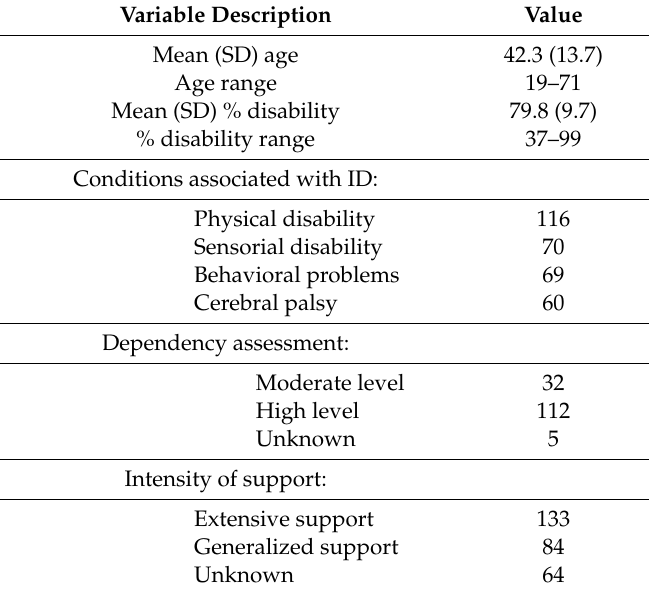
Table 1. Participants’